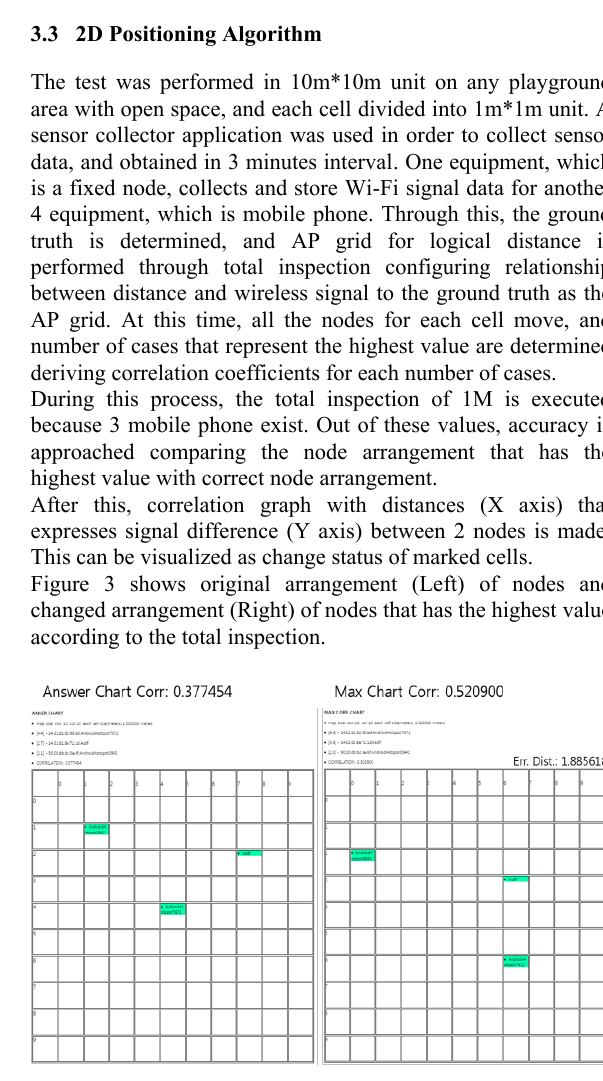
Figure 3. Node arrangement result after estimating accuracy test (Moon et al. 2015a) Comparing with the 2 space grids, the distance difference between the changed and original space grid is 1.8m, and it is accurate considerably. It is judged that this expresses accuracy of a level of average 1.5 cell, which is very meaningful results. correlation calculation of 1M was performed. That is, the processing time to find the best solutions depends on the number of nodes, which represents mobile